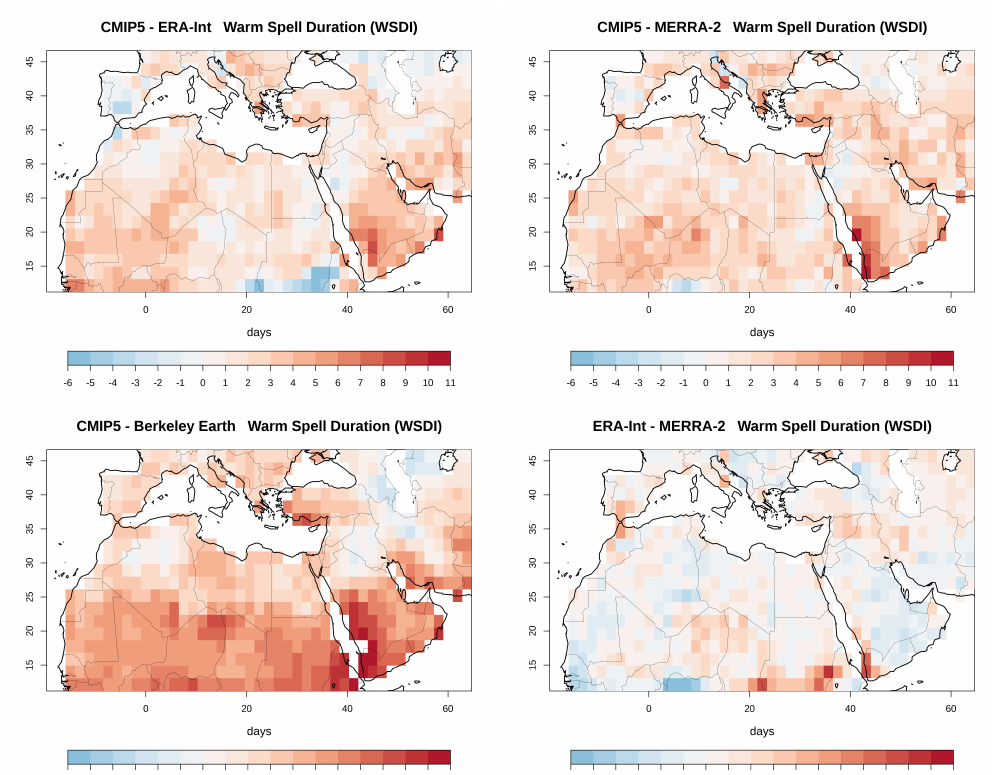
Figure A3. Same as Figure A1 but for the Warm Spell Duration